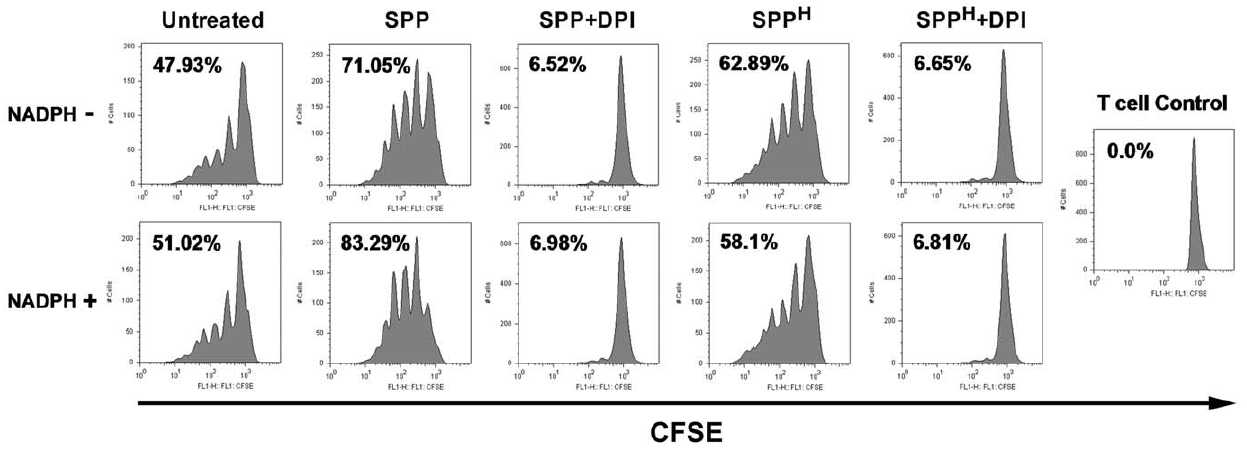
Figure 6. T cell-priming capacity of human moDCs exposed to SPPs. CFSE-labeled naı¨ve CD4 + T cells were co-cultured with allogeneic moDCs pre-treated with SPPs under various conditions as indicated on the figure. After 5 days of co-cultivation, cell division was measured by flow cytometry. Numbers indicate the proportion of viable dividing T cells. Results are representative of four independent experiments. (DPI: diphenyleneiodonium; SPP: subpollen particle; SPP H : heat-inactivated SPP).